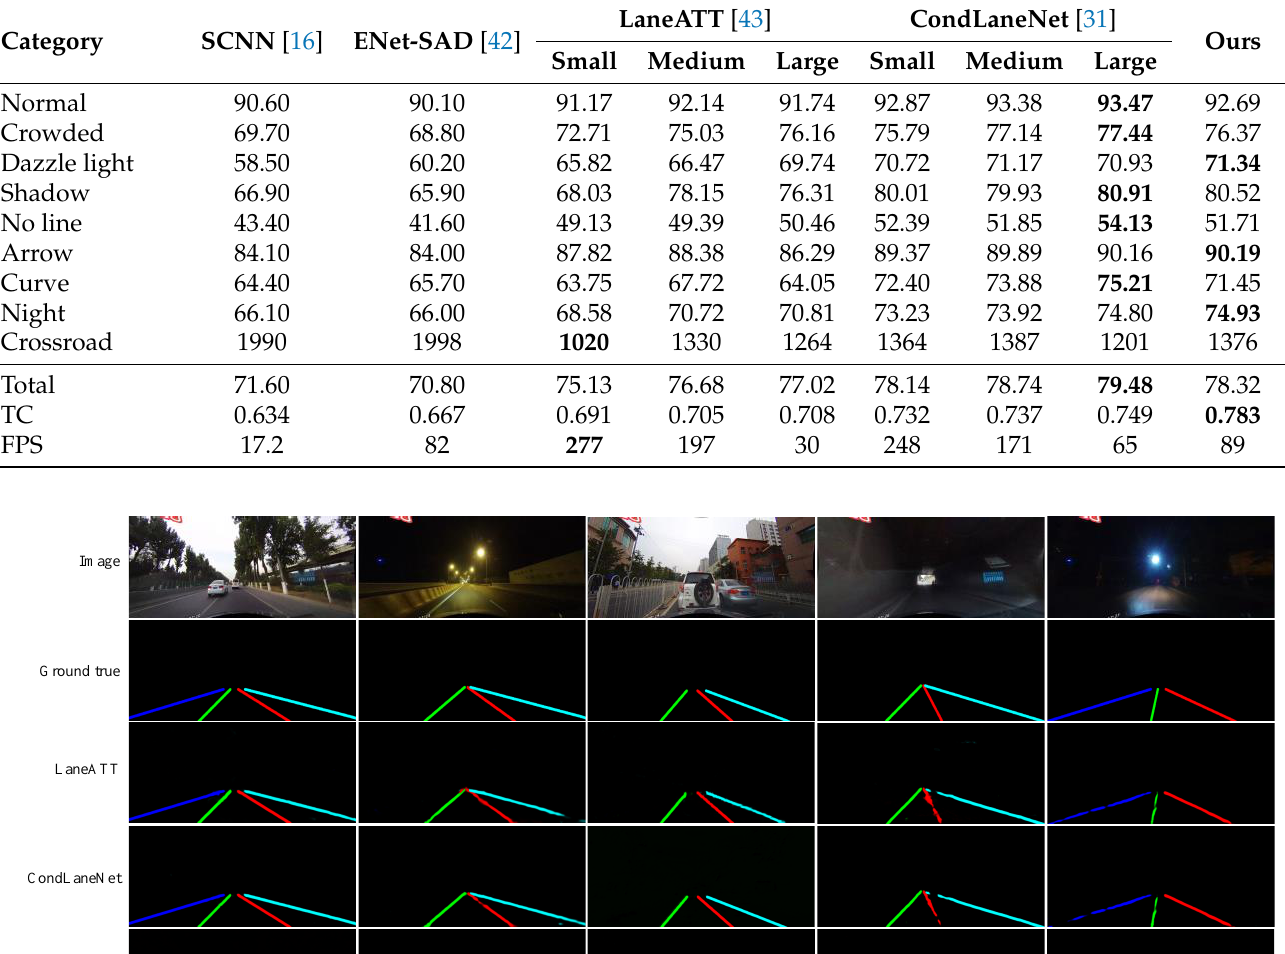
Table 5. Comparison of different methods on CULane, with an IoU threshold of 0.5. For crossroad, only FPs are shown. Category